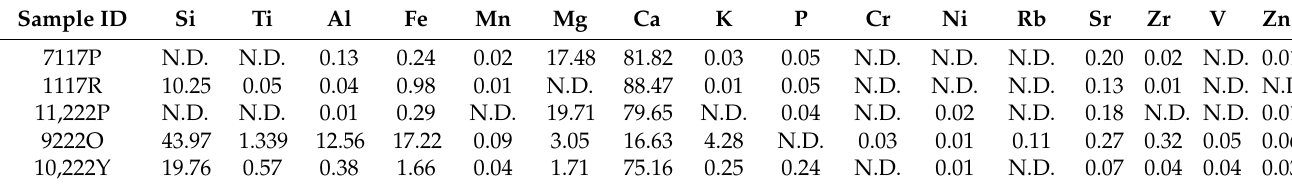
Table 1. EDXRF elemental data (wt.%) of colored stone tesserae